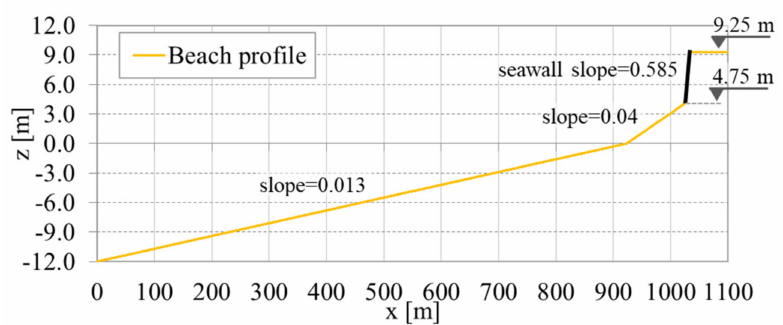
Figure 5. Bottom configuration of the real scale beach profile and seawall adopted in phase II, representative of the topo-bathymetric characteristics of the study site in Cova-Gala.